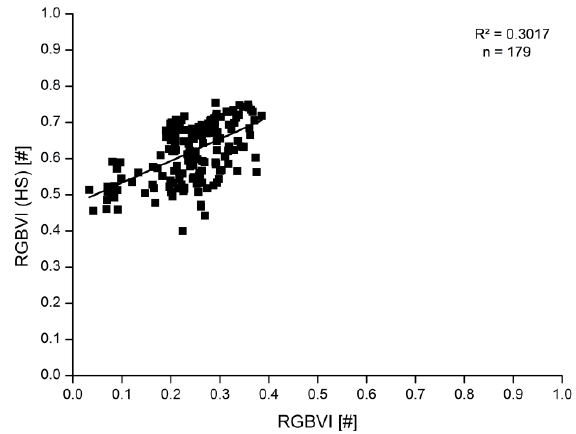
Figure 7. RGBVI from overview photos versus Red Green Blue Vegetation Index from hyperspectral measurements, G 2 &